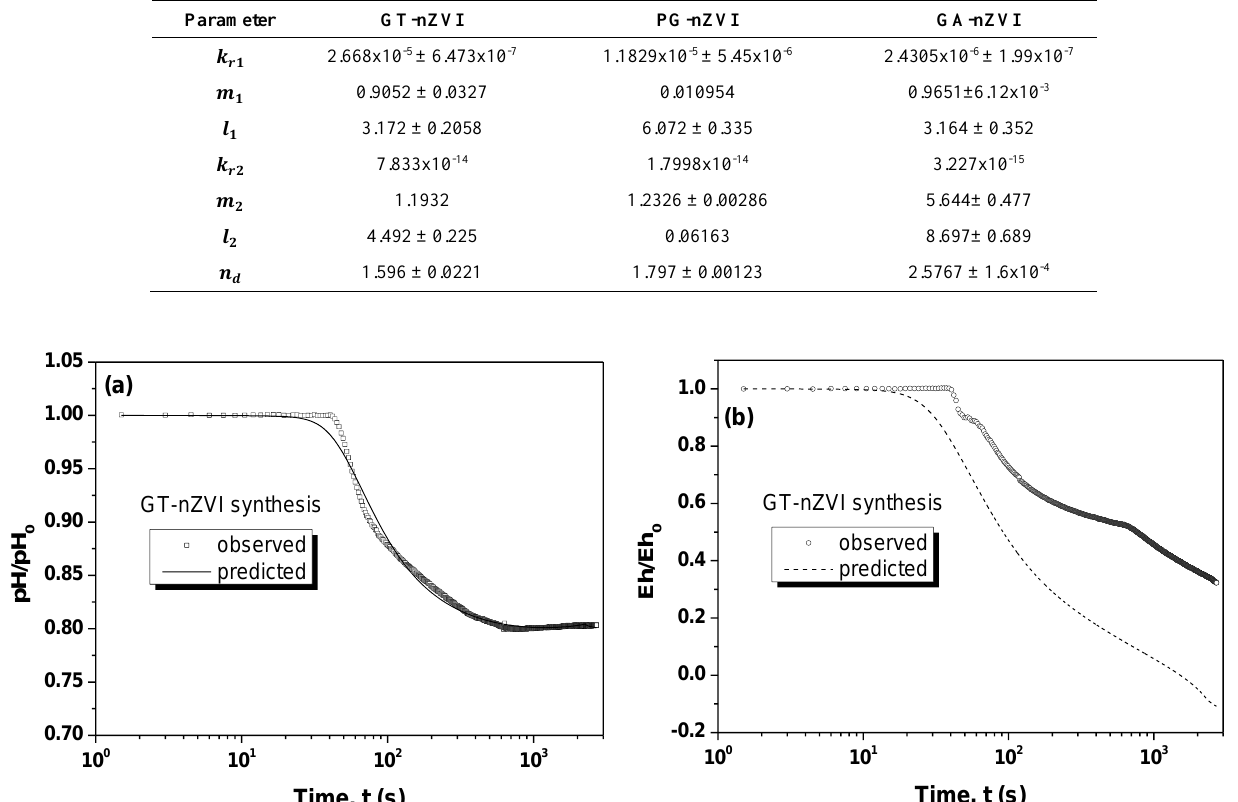
Figure 9. Comparison of experimentally measured with numerically predicted (a) pH/pH 0 , and (b) E h /E h0 , when ferrous ions are reduced to zero valent iron by the polyphenols of Green Tea extract